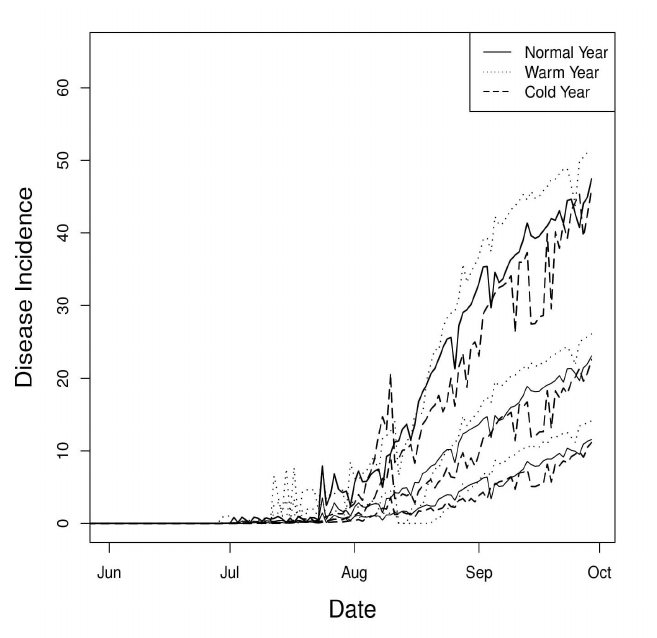
Figure 10. Sensitivity analysis of model predicted DI for Chancellor (top), Geisenheim-318 (middle), and Frontenac (bottom) cultivars, by changing temperature by 2 ◦ C (warm and cold year scenarios). Daily temperature in 2011 is shown as a reference baseline (solid line).